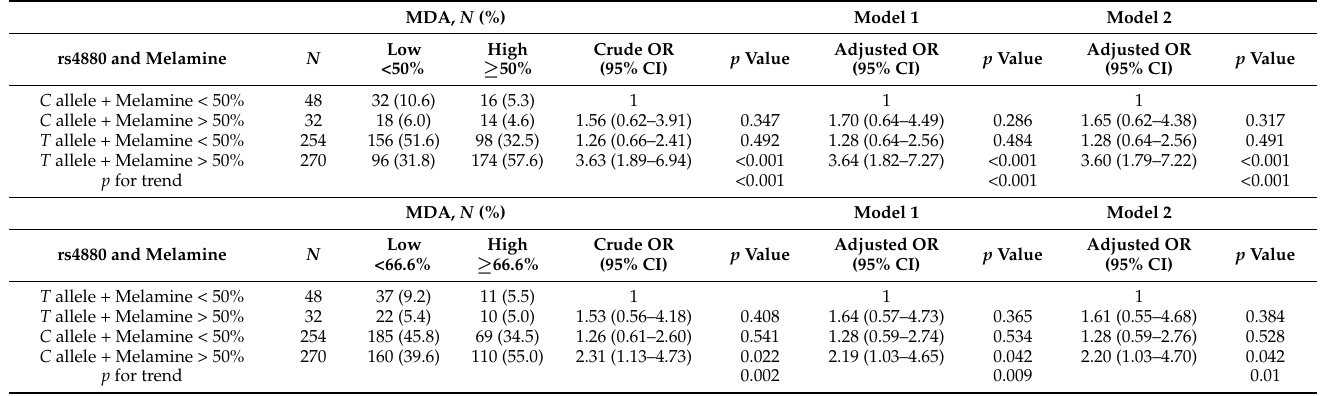
Table 5. Combined effects of MnSOD genetic polymorphism (rs4880) and urine melamine levels on the risk of a high urinary marker of oxidative stress, MDA, in 302 calcium urolithiasis patients.